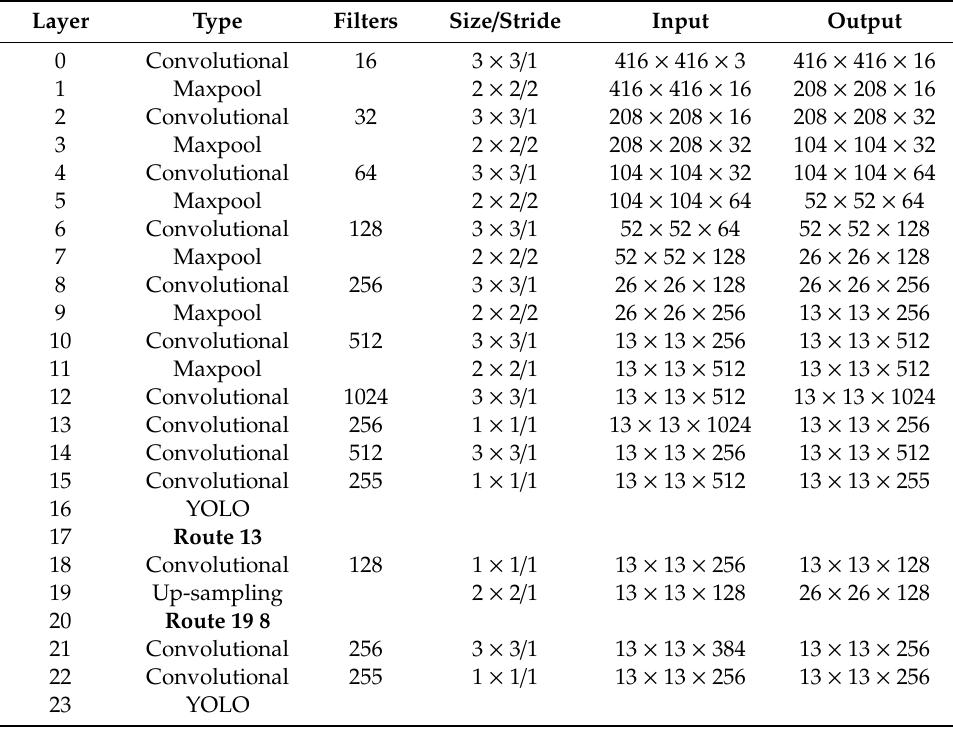
Table 1. You Only Look One v3-tiny (YOLOv3-tiny) network